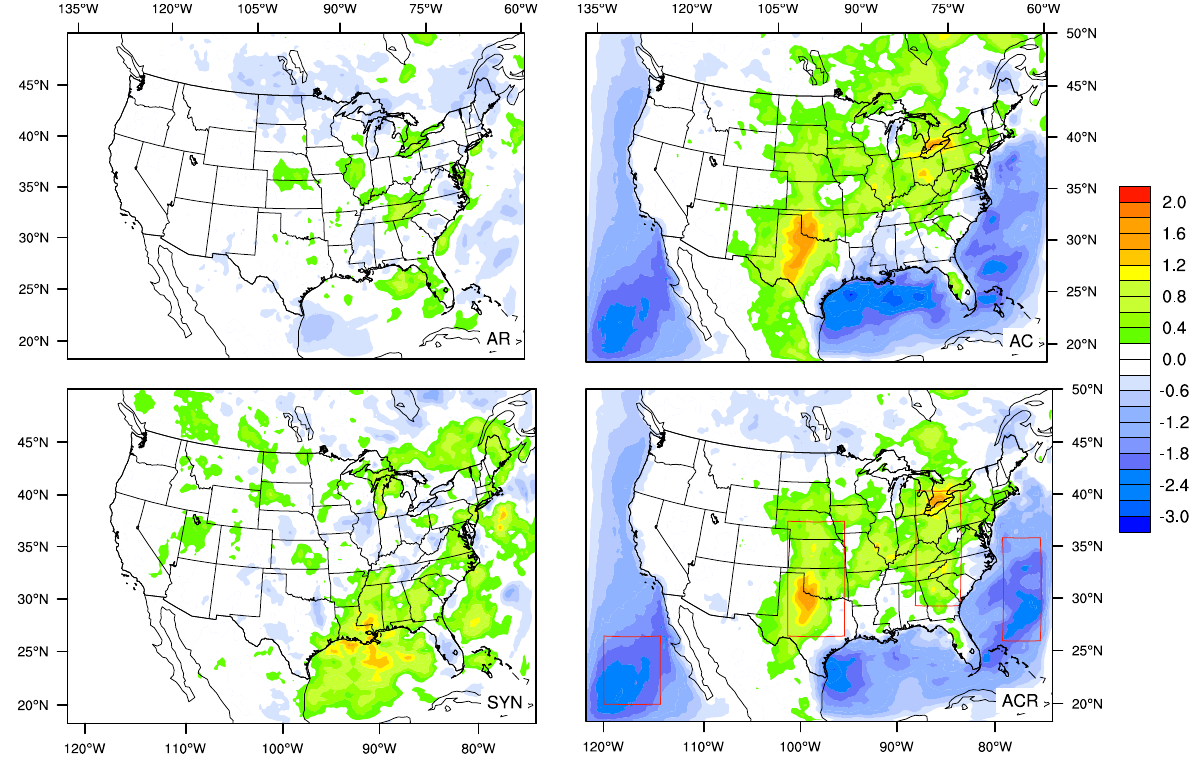
Figure 8. Spatial distribution of changes in the three-month average surface ozone concentration (ppbv) due to AR, AC, SYN, and ACR. Regions in red boxes are subject to temporal analysis.